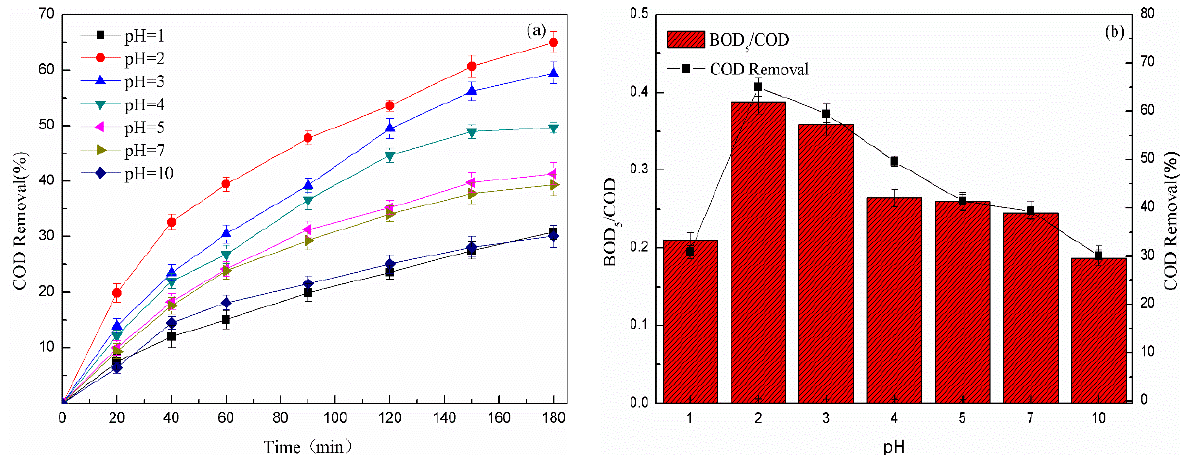
Figure 4. Effect of initial pH on ( a ) COD removal and ( b ) BOD 5 /COD of chemical pharmaceutical wastewater (Fe-Mn- Cu@ATP dose = 10.0 g/L, hydrogen peroxide concentration = 0.5 mol/L, light distance =20 cm).